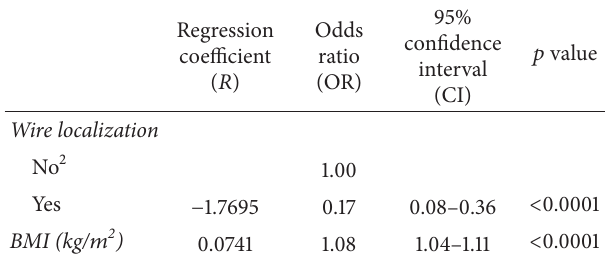
Table 4: Multivariable stepwise logistic regression modeling for risk factors 1 in association with